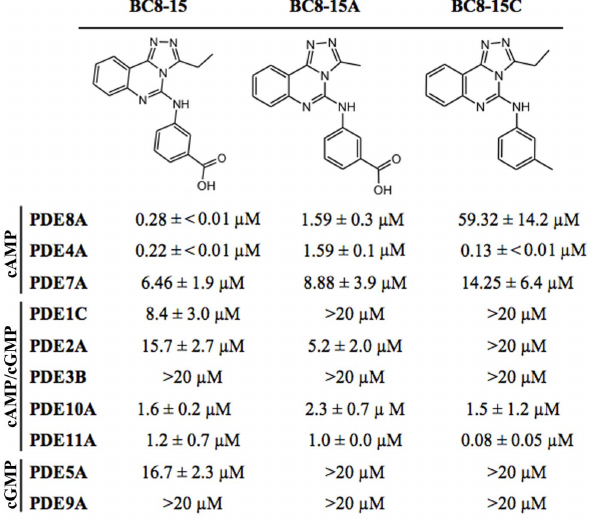
Figure 3. IC 50 values for BC8-15 and related compounds. The structures of BC8-15 and two structurally-related derivatives are shown. The IC 50 values of each compound were determined by in vitro PDE assays (see Material and Methods). The values represent mean IC 50 6 SD determined from three independent experiments.